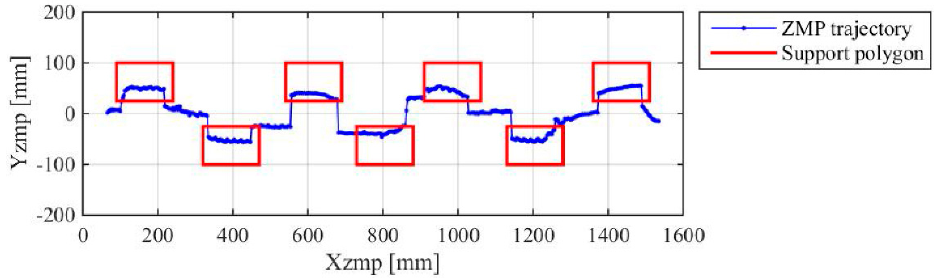
Figure 17. ZMP trajectory of the biped robot in the case of walking with the new feet.